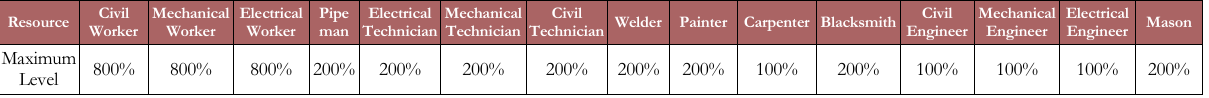
Table 8. Maximum Available Resource